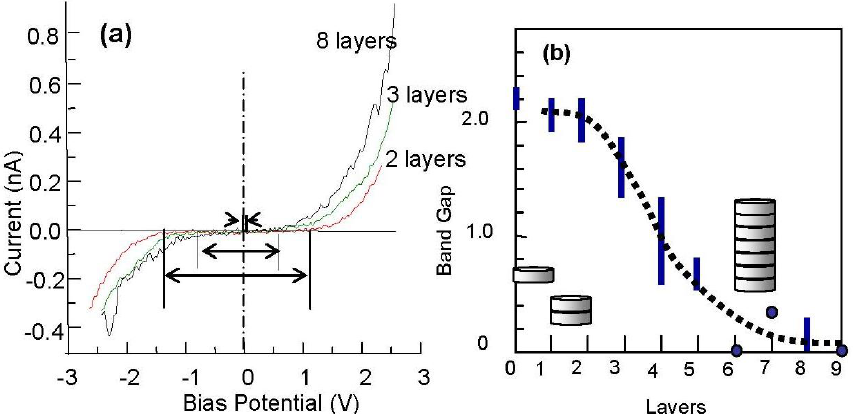
Figure 22. ( a ) STS of Ag dots grown on the Si(111)-7 × 7-C of Ag-dots changes from semiconductor to metal depending on the height